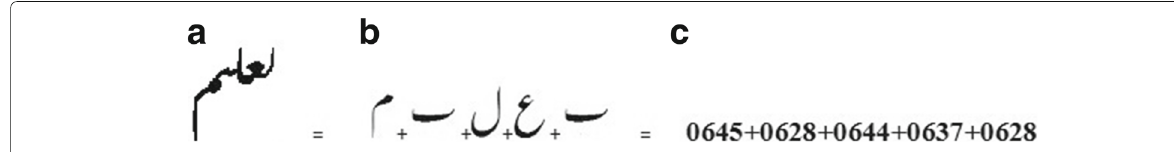
Fig. 7 a Sample primary ligature. b Constituent character classes. c Respective Unicodes